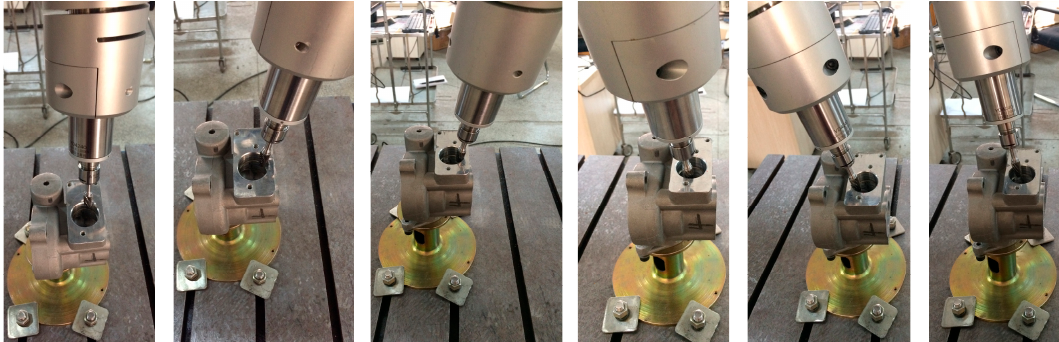
Figure 22. Experimental deburring of orifice edges on top facet.